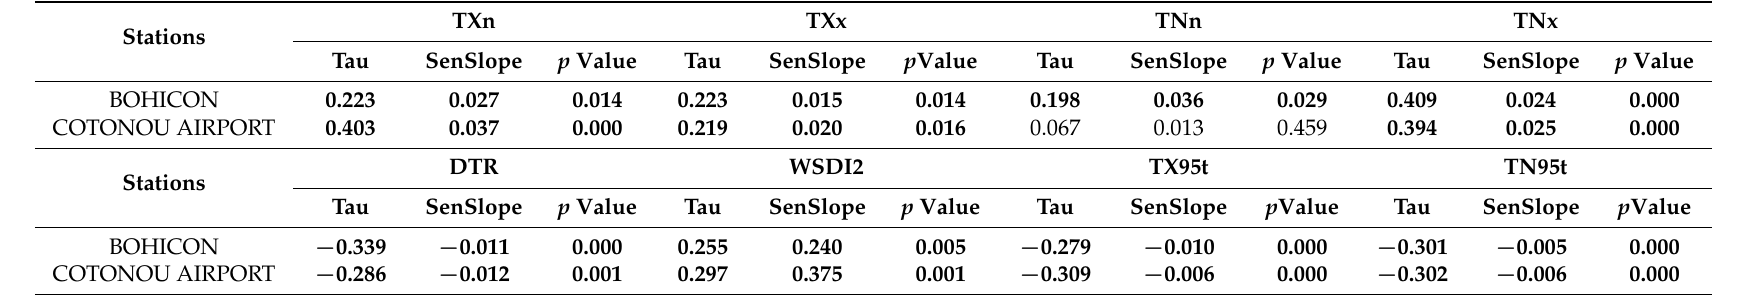
Table 10. Temperature based indices trend.